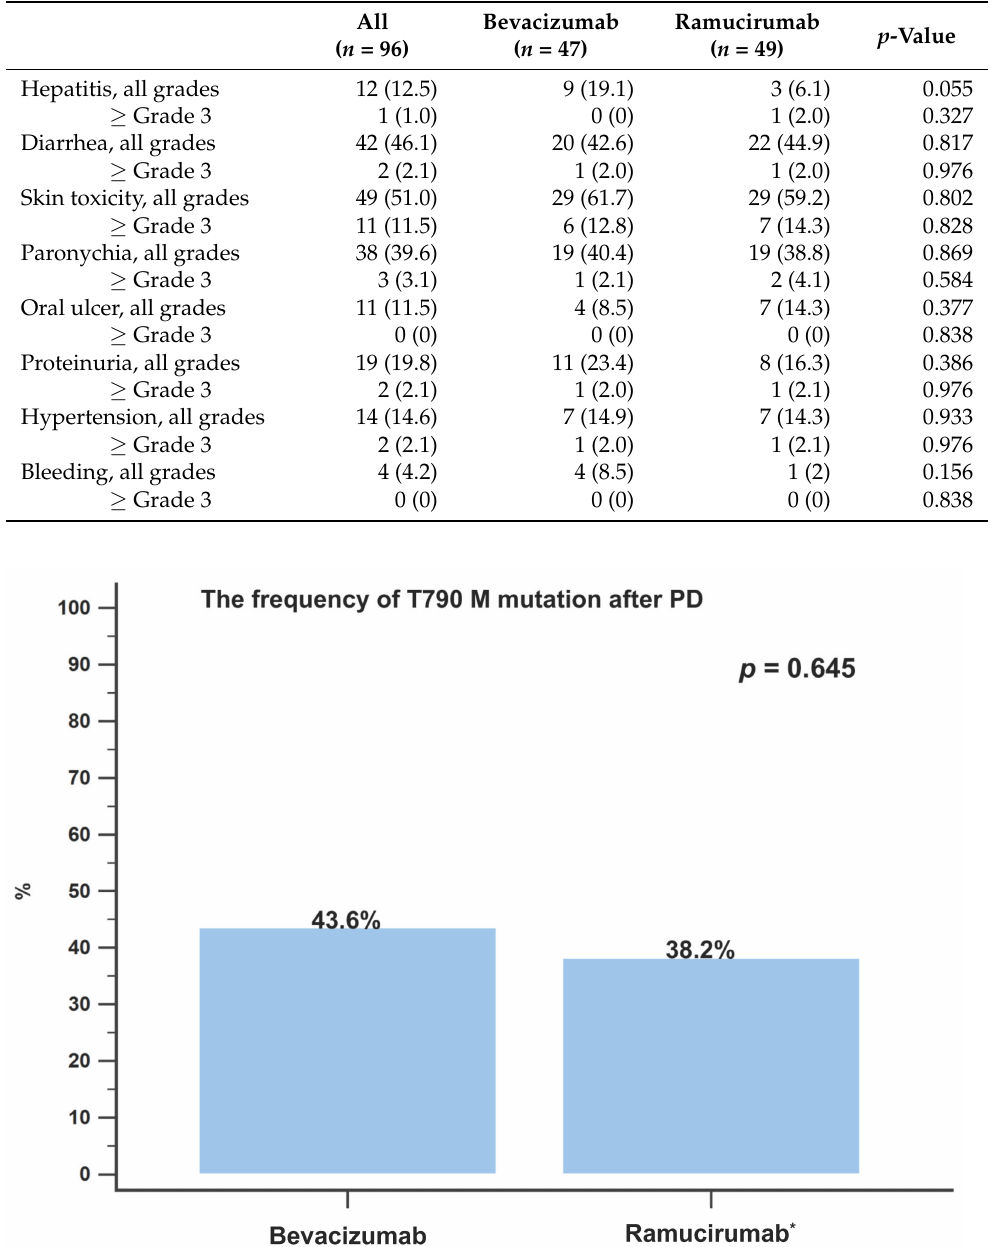
Table 2. Adverse events in EGFR-mutated metastatic non-small-cell lung cancer patients receiving bevacizumab or ramucirumab in combination with epidermal growth factor receptor-tyrosine kinase inhibitor therapy.